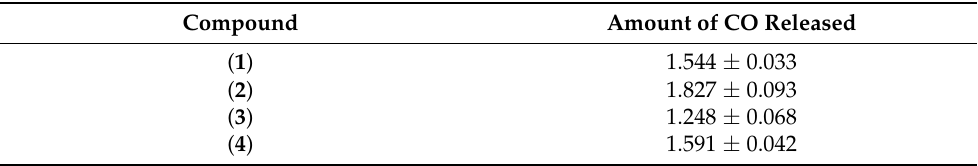
Table 5. Equivalent amount of CO released per mol of the compounds ( 1 )–( 4 ) during UV light irradiation ( λ em = 395 ± 5